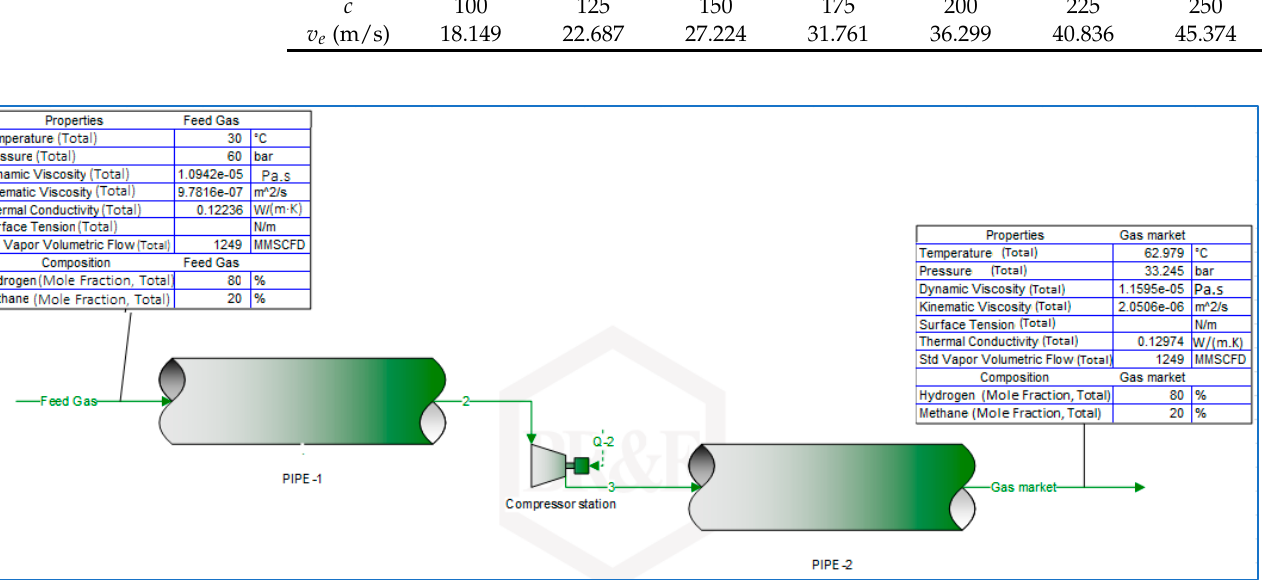
Figure 6. Compressor station option model for 80% hydrogen and 20% natural gas blend.